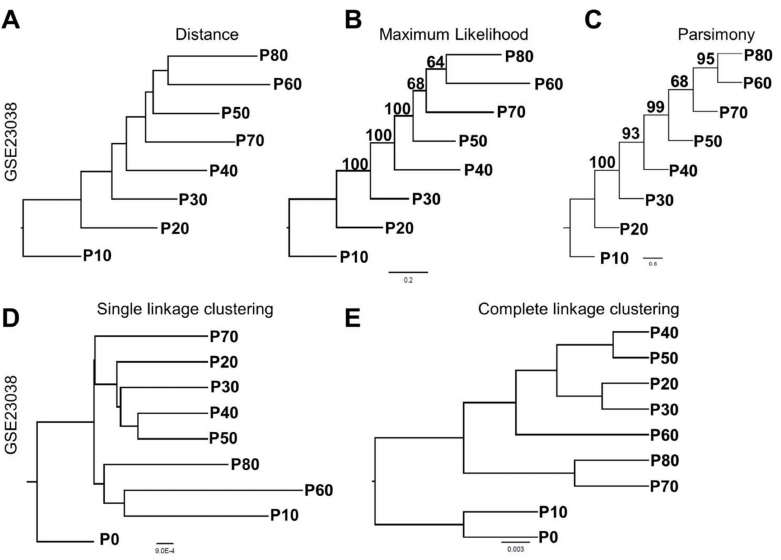
Figure 2. Phylogenetic reconstruction provides a simple visualization tool to view temporal changes in gene expression data. ( A ) Distance-based phylogeny of GSE23038; serial passage of normal prostate cells immortalized with hTERT using gene expression data as a continuous variable. ( B ) Maximum-likelihood and ( C ) maximum parsimony trees constructed based on gene expression data transformed to categorical variables. ( D ) Single and ( E ) complete linkage hierarchical clustering provides similar groupings of passage numbers, but lacks the temporal structure.